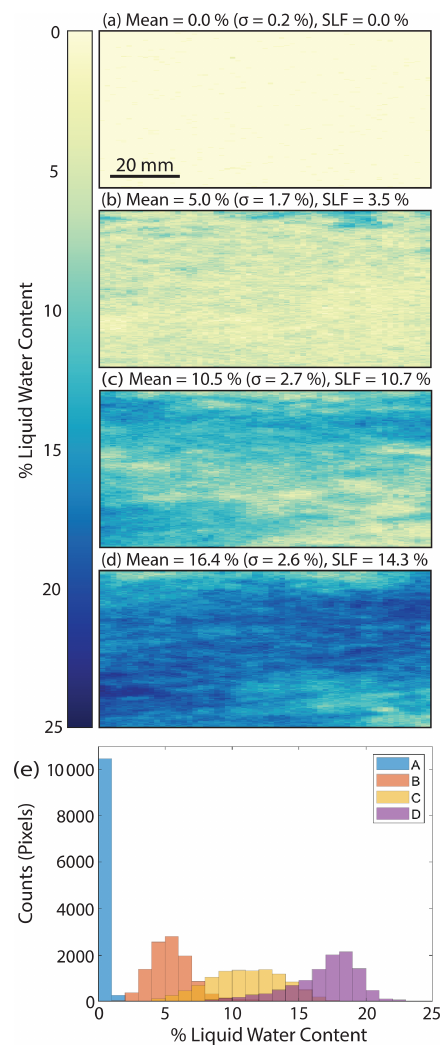
Figure 8. (a–d) Time series liquid water content mapping over a single region of interest during a laboratory experiment. (e) Liquid water content distribution in images (a–d) shown in a